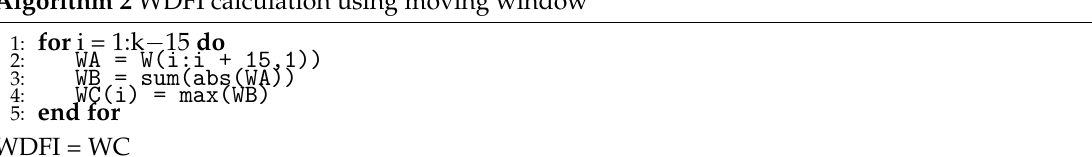
Algorithm 2 WDFI calculation using moving